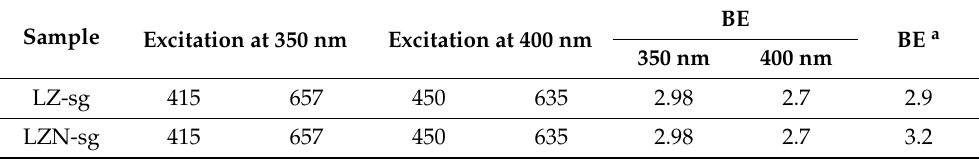
Figure 11. EDS spectra ( a , b ) and the corresponding captured area ( c , d ) of LZ-sg and LZN-sg pyro- chlores.